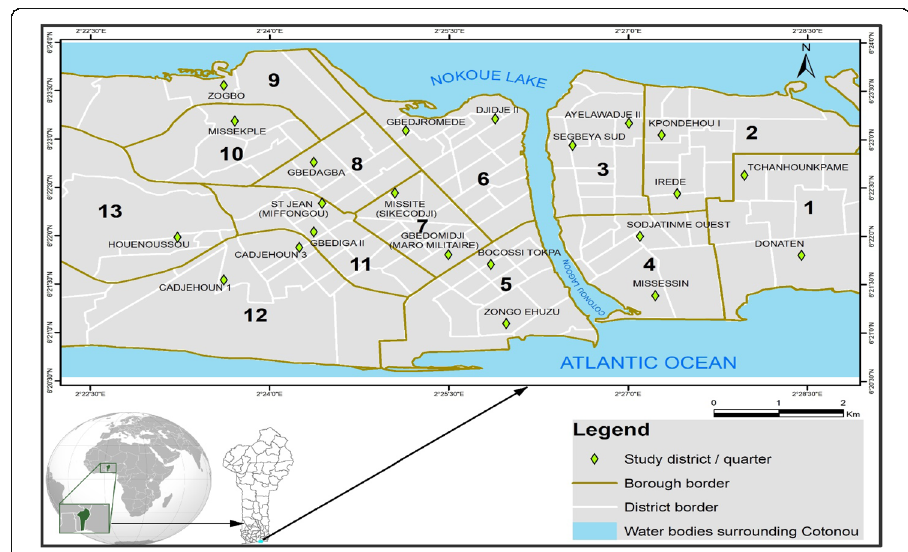
Fig. 1 Location of the streets of sample “ atta ” microenterprises in the city of Cotonou. Source: Map by Evrard AKPLA with survey data provided by Claudia